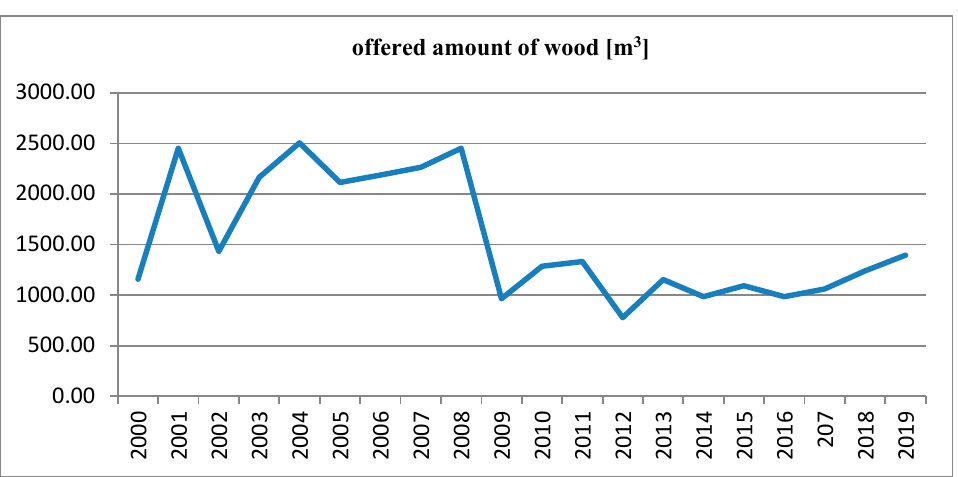
Figure 1. Offered amount of wood on RDSF Krosno submissions (in m 3 ).